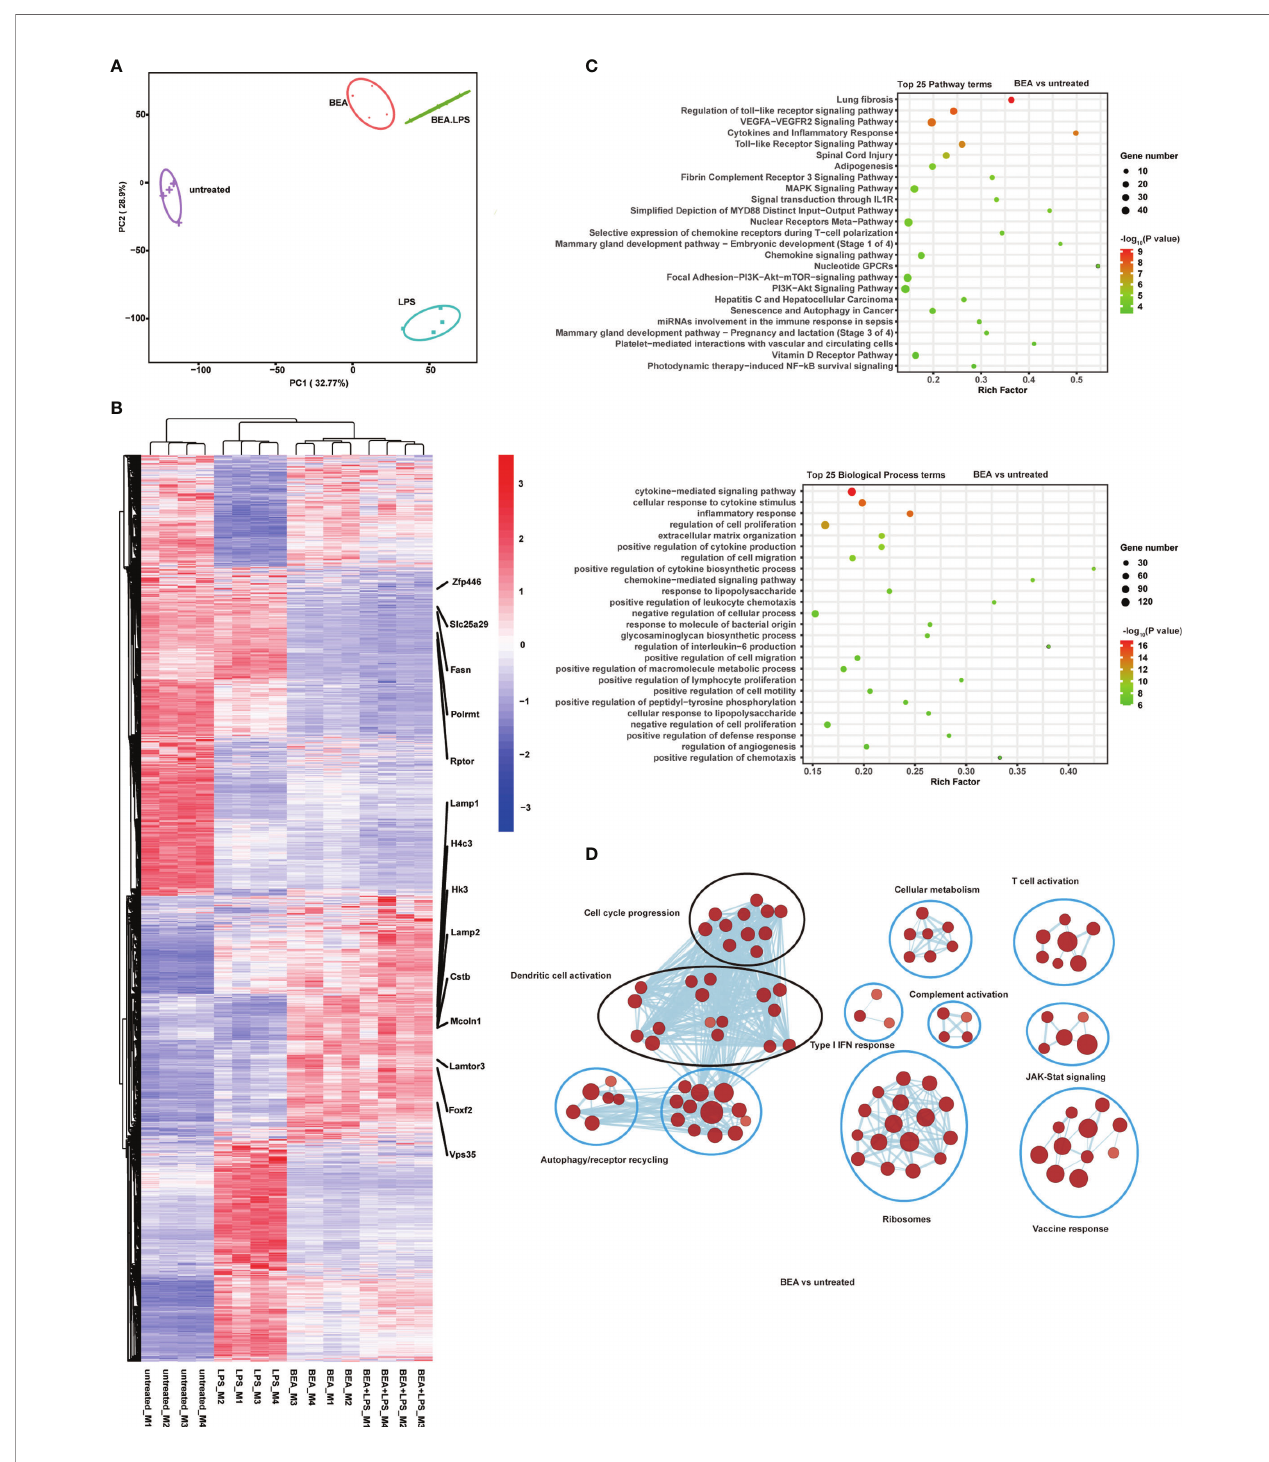
FIGURE 6 | BEA promotes transcriptional changes associated with chemokine and cytokine production and TLR signaling pathway activation but are distinct from LPS stimulation. MHC II high CD11c + BMDCs sorted by fl ow cytometry were followed by stimulation with BEA (5 µM) or LPS (1 m g/ml) alone or BEA combined with LPS for 4 hours. Results shown are from one experiment containing 4 independent biological replicates (cells from 4 mice per group, n=4) for each condition. (A) PCA of the quadruplicate biological replicates. (B) Heatmap showing expression pro fi le for 4,015 genes that were found to be signi fi cantly regulated in at least one of the comparisons using untreated as baseline condition. (C) Enriched Reactome pathways (upper plot) and biological process (lower plot) in DEGs in BEA treated BMDCs compared with untreated BMDCs. (D) Cytoscape representation of signi fi cantly enriched signatures in BEA treated BMDCs compared with untreated